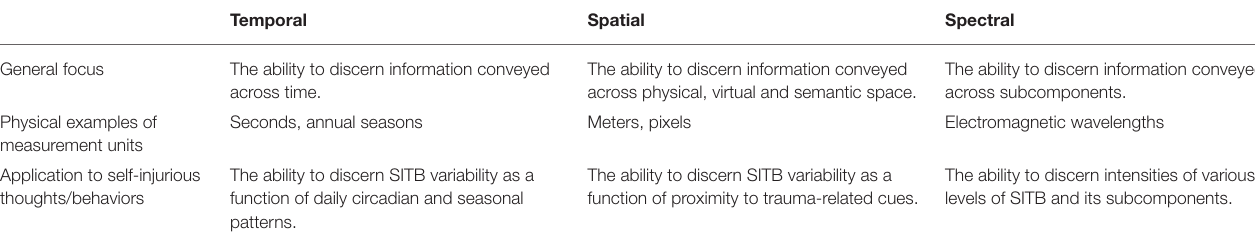
TABLE 1 | “Resolution” types discussed in this article. Temporal Spatial